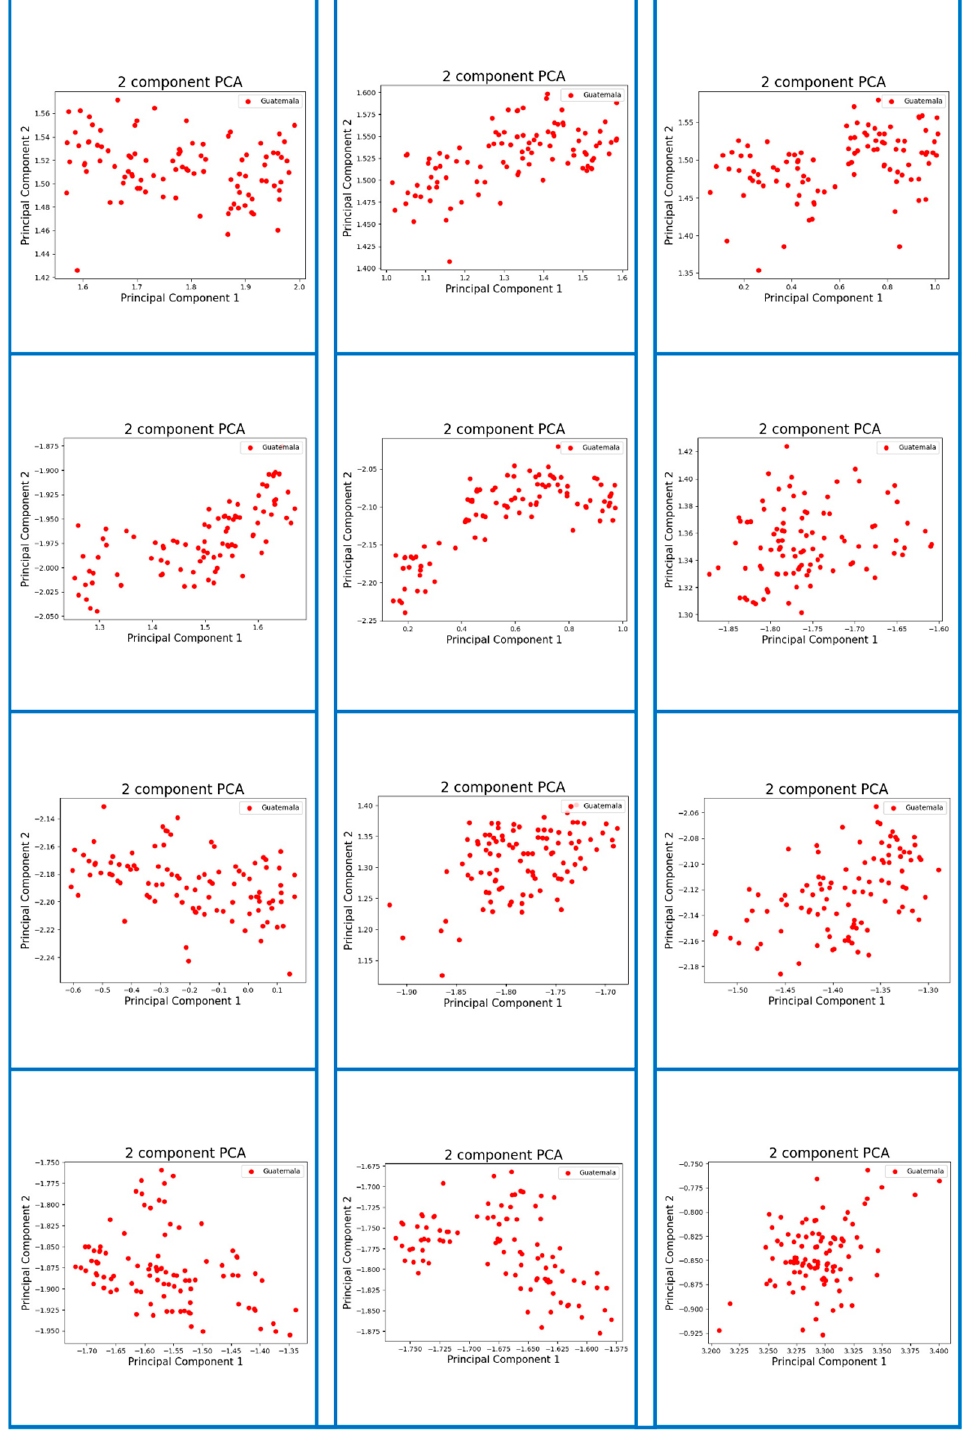
Figure A1. Sample digital fingerprints of coffee aromas originating from Guji Uraga, Ethiopia.